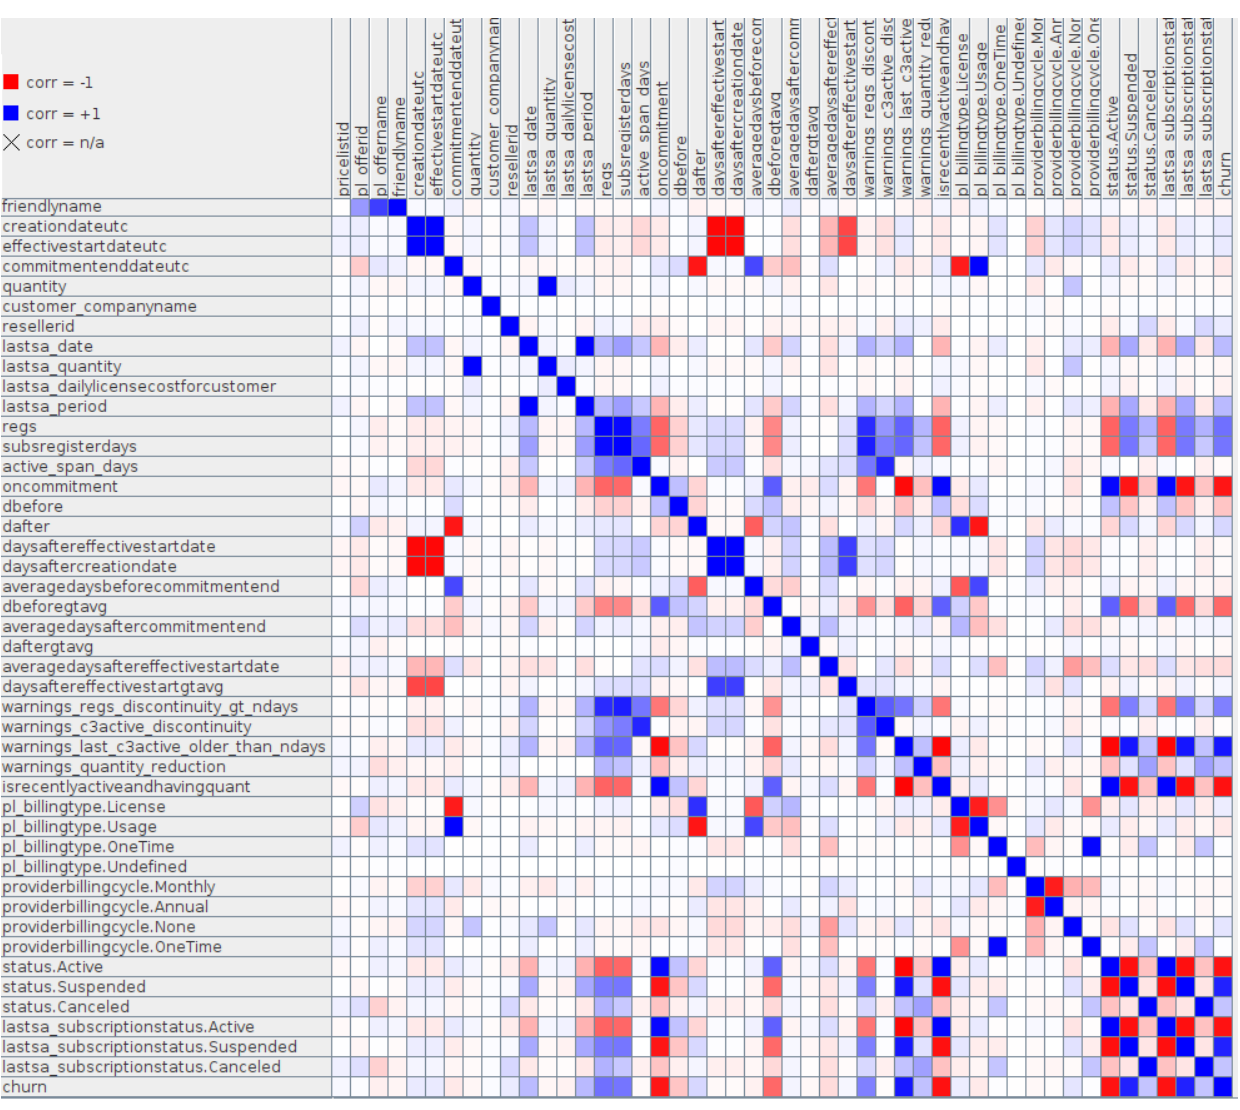
Figure 2. Correlation matrix: pair-wise correlation values of selected data columns. Table 1. Churn correlation and statistical